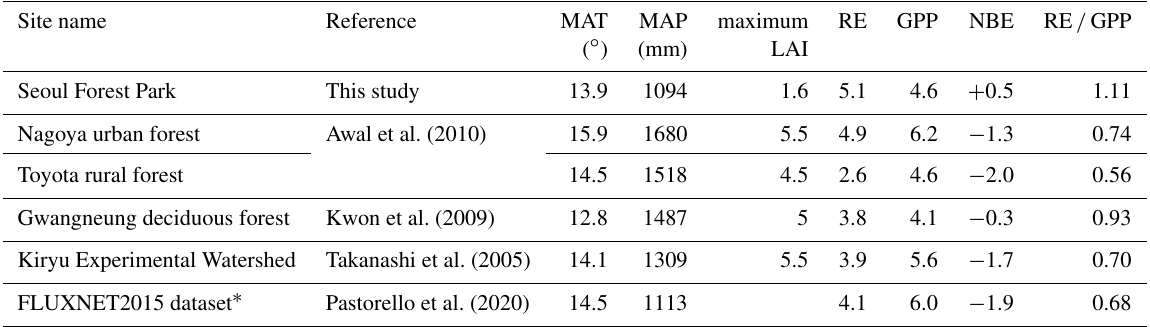
Table 5. Annual budgets of biogenic F C components and ratios in deciduous broadleaf forests in similar climatic conditions reported in previous studies. All fluxes are in kgCO 2 m − 2 yr − 1